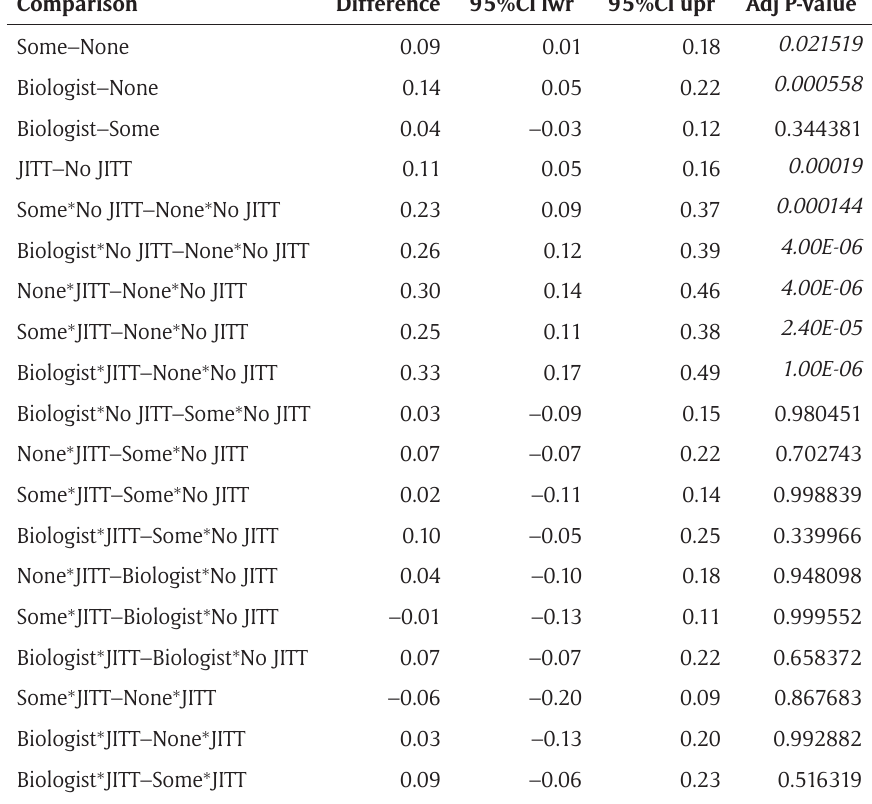
Table 2: Tukey-Kramer Honestly Significant Difference results comparing differences in mean accuracy between treatment groups.